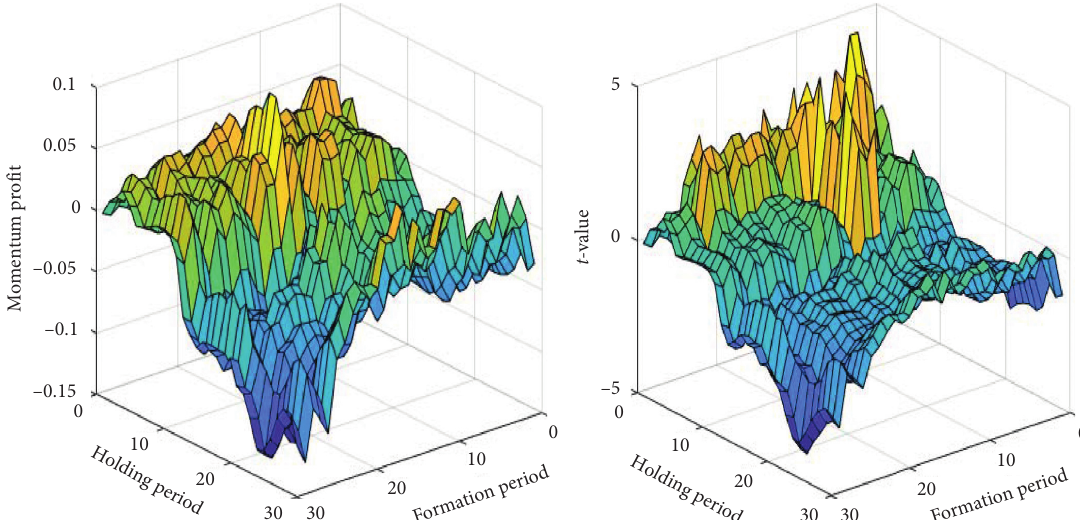
Figure 9: Lowest daily relative order imbalance in extensions of the B-share market. This figure shows the momentum profits and t -statistics under the lowest daily relative order imbalance in extensions of the B-share market. The formation and holding periods, respectively, range from 1 day to 30